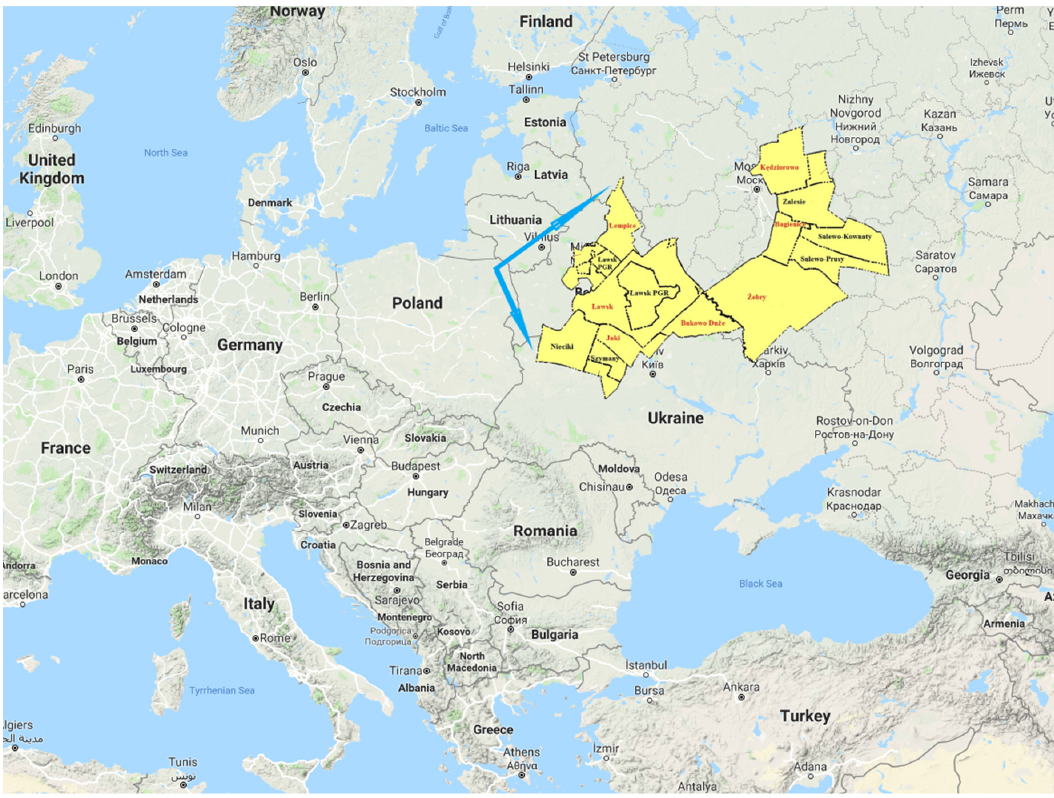
Figure 2. The map showing the study area position. Source: own study on [52].